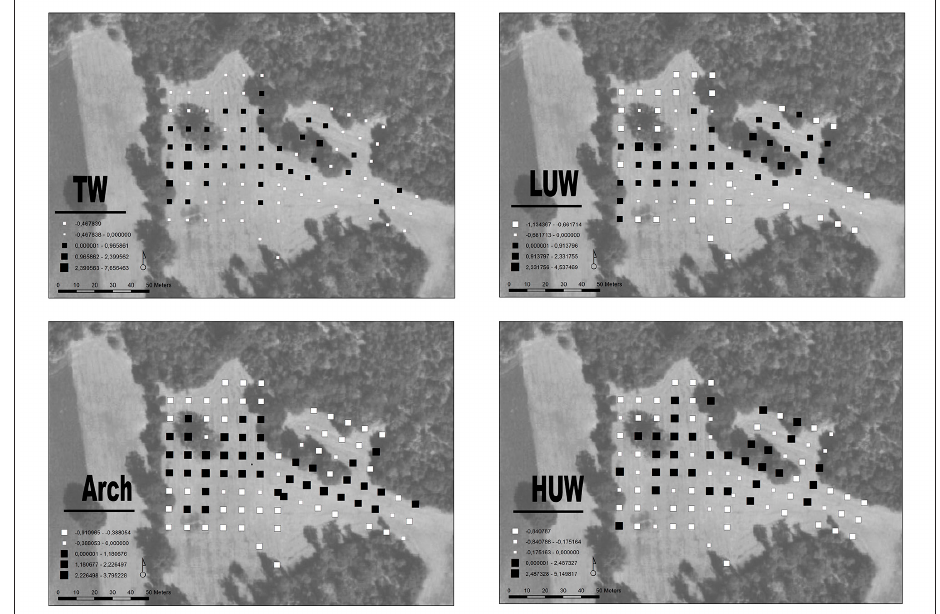
Figure 6: PCA-standardized values of site A205 in a